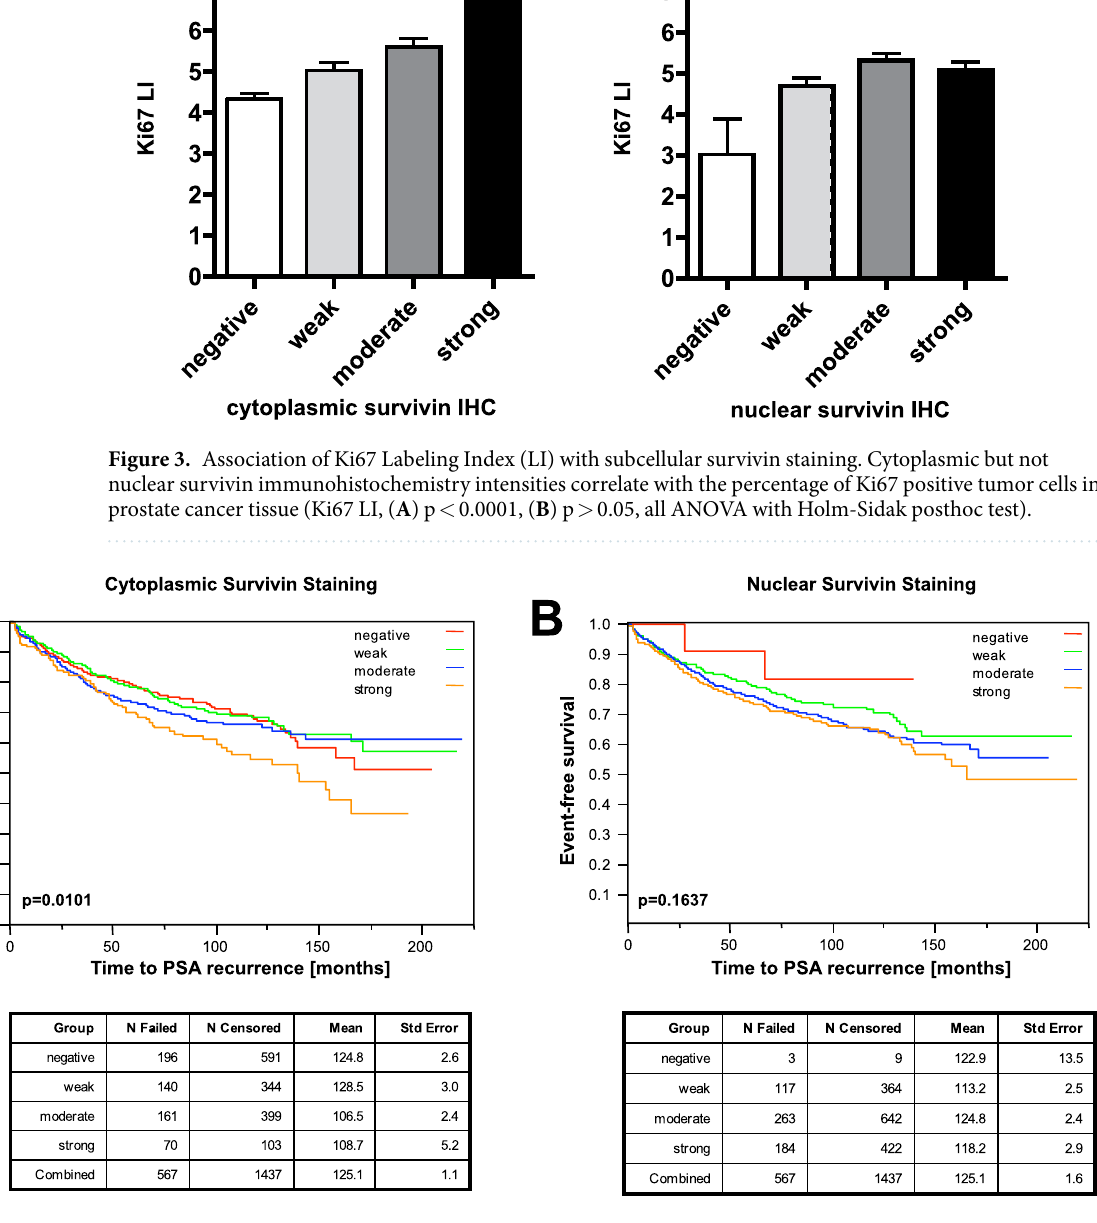
Figure 4. Association of subcellular survivin staining with PSA-free survival after prostatectomy. Kaplan-Meier curves of immunohistochemical staining intensities show the influence of the subcellular survivin distribution on PSA recurrence: strong cytoplasmic staining is associated with an impaired PSA-free survival ( A , p = 0.0101, Log-Rank test), whereas nuclear survivin staining is not ( B , p = 0.1637, Log-Rank